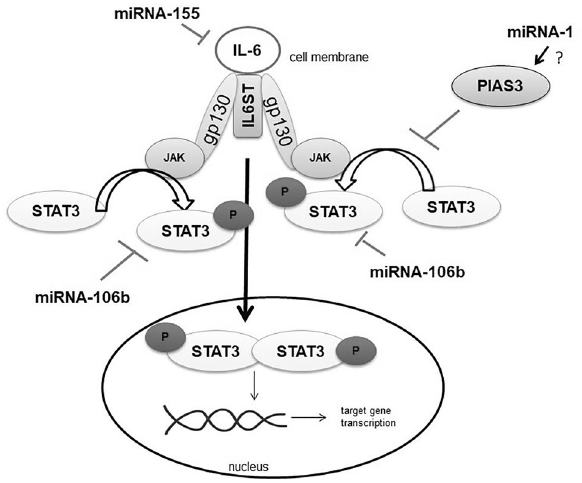
Figure 1. The IL-6/JAK/STAT3 signaling pathway. IL-6—interleukin 6. JAK—Janus kinase, IL6ST, gp130 (glycoprotein 130)—receptor for interleukin6, STAT3—signal transducer and activator of transcription 3, P—